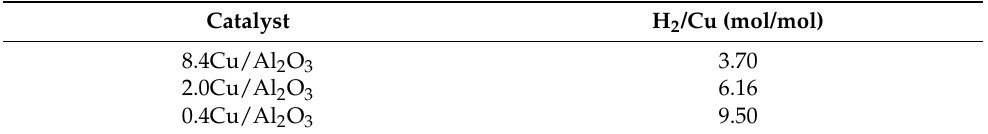
Table 8. The catalytic activity of copper catalysts prepared using the wet impregnation method with different Cu loadings and tested at 800 ◦ C and 1 atm [86].